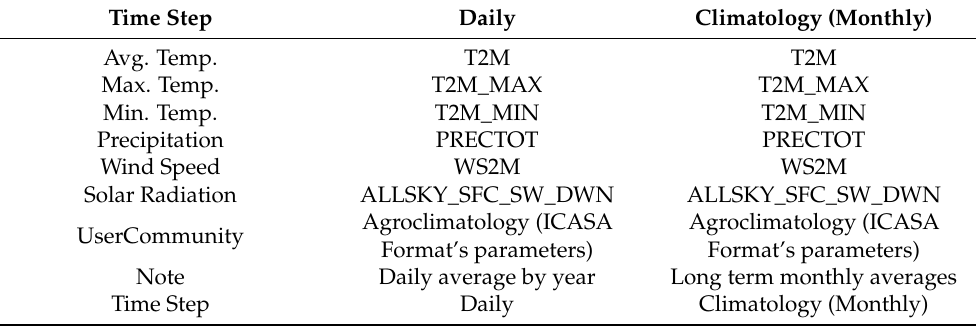
Table 1. Weather variables extracted using NASA POWER API.